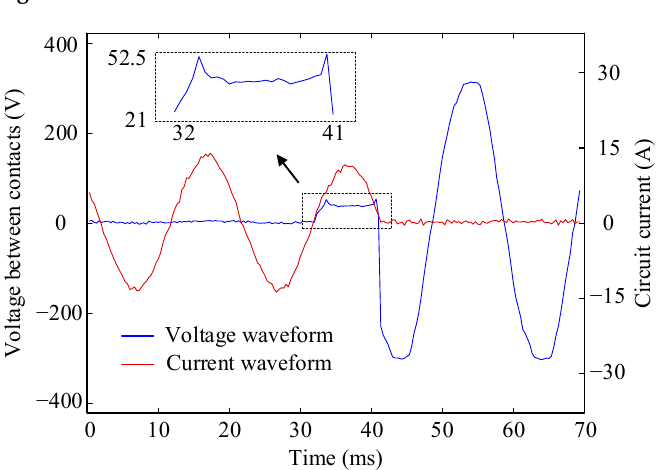
Figure 12. The electrical life test device.